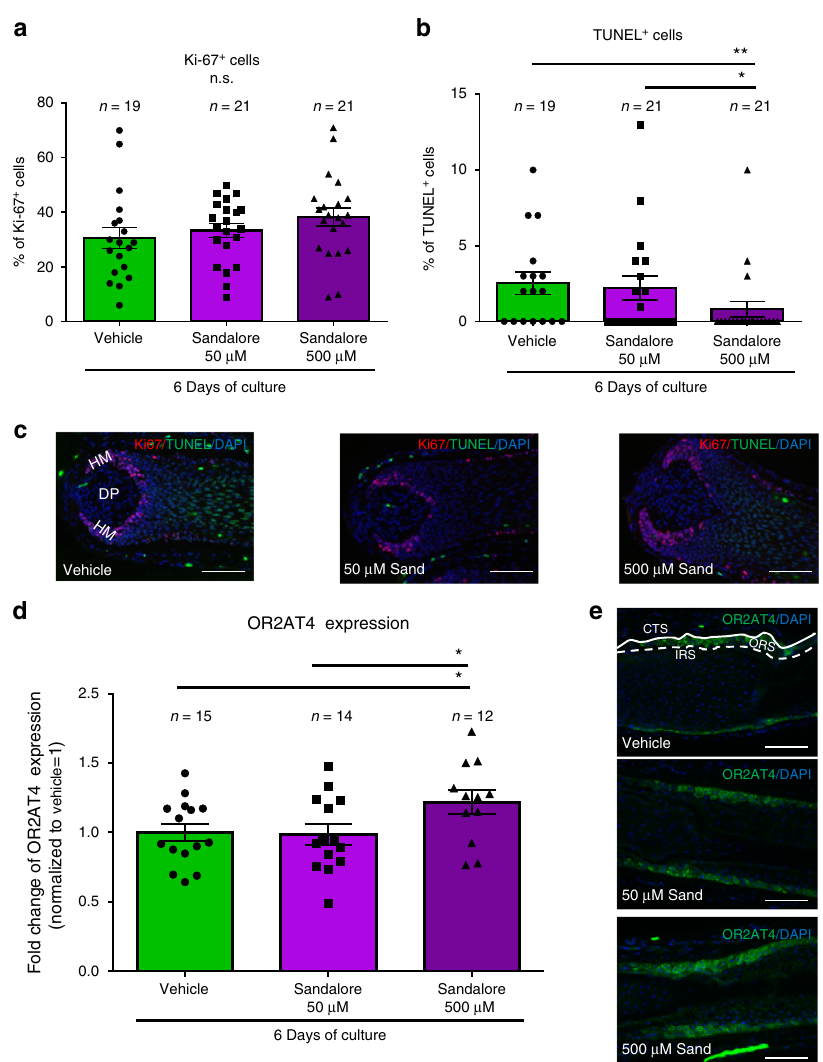
Fig. 3 High concentration of Sandalore ® (500 µ M) regulates hair matrix keratinocytes apoptosis and intrafollicular OR2AT4 expression. a , b The number of Ki-67 + and TUNEL + cells in the hair matrix was evaluated in the hair bulb of all treated and vehicle HFs. c Representative pictures of Ki-67/TUNEL staining. Mean± SEM, n = 19 – 21 HFs from two donors (independent experiments), unpaired Student ’ s t -test or Mann – Whitney test, * P < 0.05, ** P < 0.01. DP dermal papilla, HM hair matrix. Scale bar: 100 µ m. d OR2AT4 protein expression was evaluated using ImageJ in the ORS of Sandalore ® -treated and control HFs after 6 days of culture. e Representative pictures of OR2AT4 expression in the ORS of cultured HFs. Mean ± SEM, n = 12 – 15 HFs from two donors (independent experiments), Student ’ s t -test, * P < 0.05. CTS connective tissue sheath, IRS inner root sheath, ORS outer root sheath. Scale bar: 100